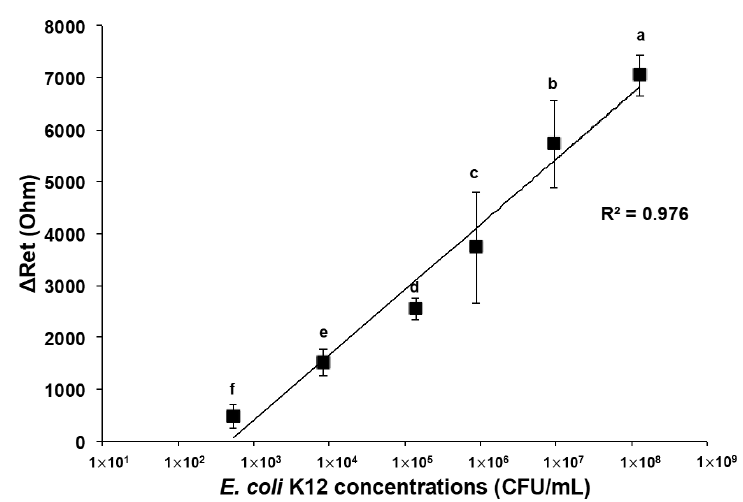
Figure 5. Electrochemical impedance spectra of the E. coli MEI sensor without E. coli K12 cell attachment and with E. coli K12 cells binding to the surfaces.